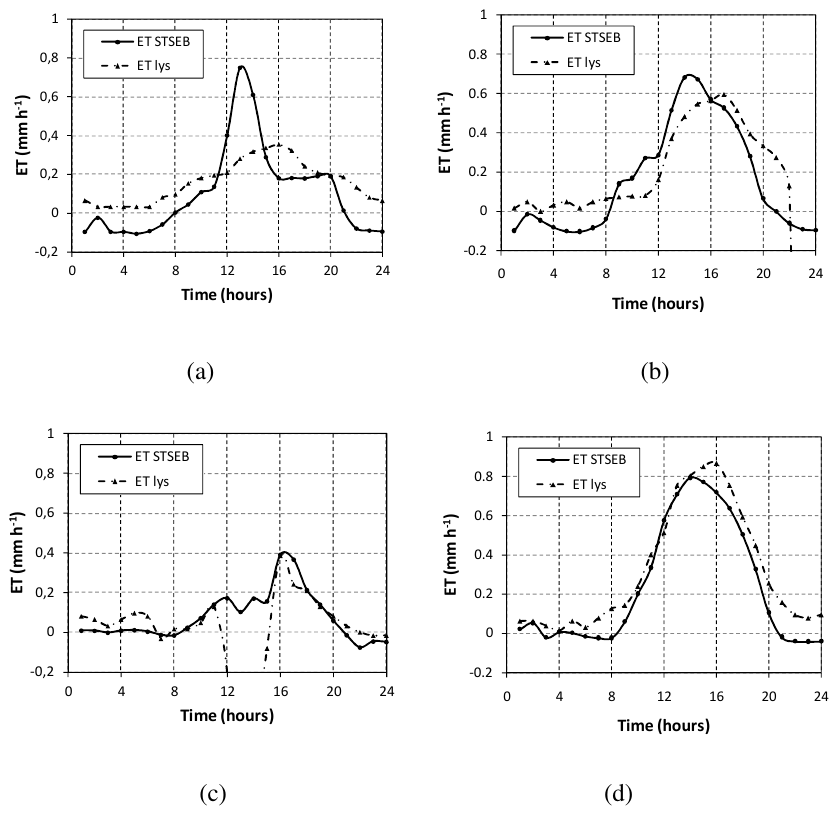
Fig. 5. Diurnal evolution of the estimated and measured sorghum ET: (a) DOY 184, (b) DOY 185, (c) DOY 229, (db) DOY 236. Figure 5. Diurnal evolution of the estimated and measured sorghum ET: (a) DOY 184, 6 (b) DOY 185, (c) DOY 229, (d) DOY 236. 7